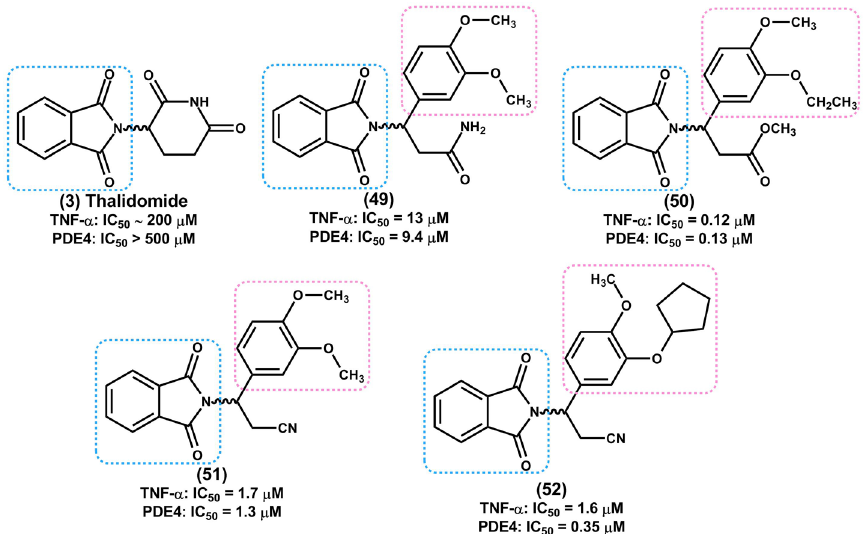
FIGURE 5 - Inhibitory activity of thalidomide ( 3 ) and analogues ( 49-52 ) in the TNF-α release in peripheral blood mononuclear cells stimulated by LPS and in the enzymatic activity of PDE4 (Muller et al. ,